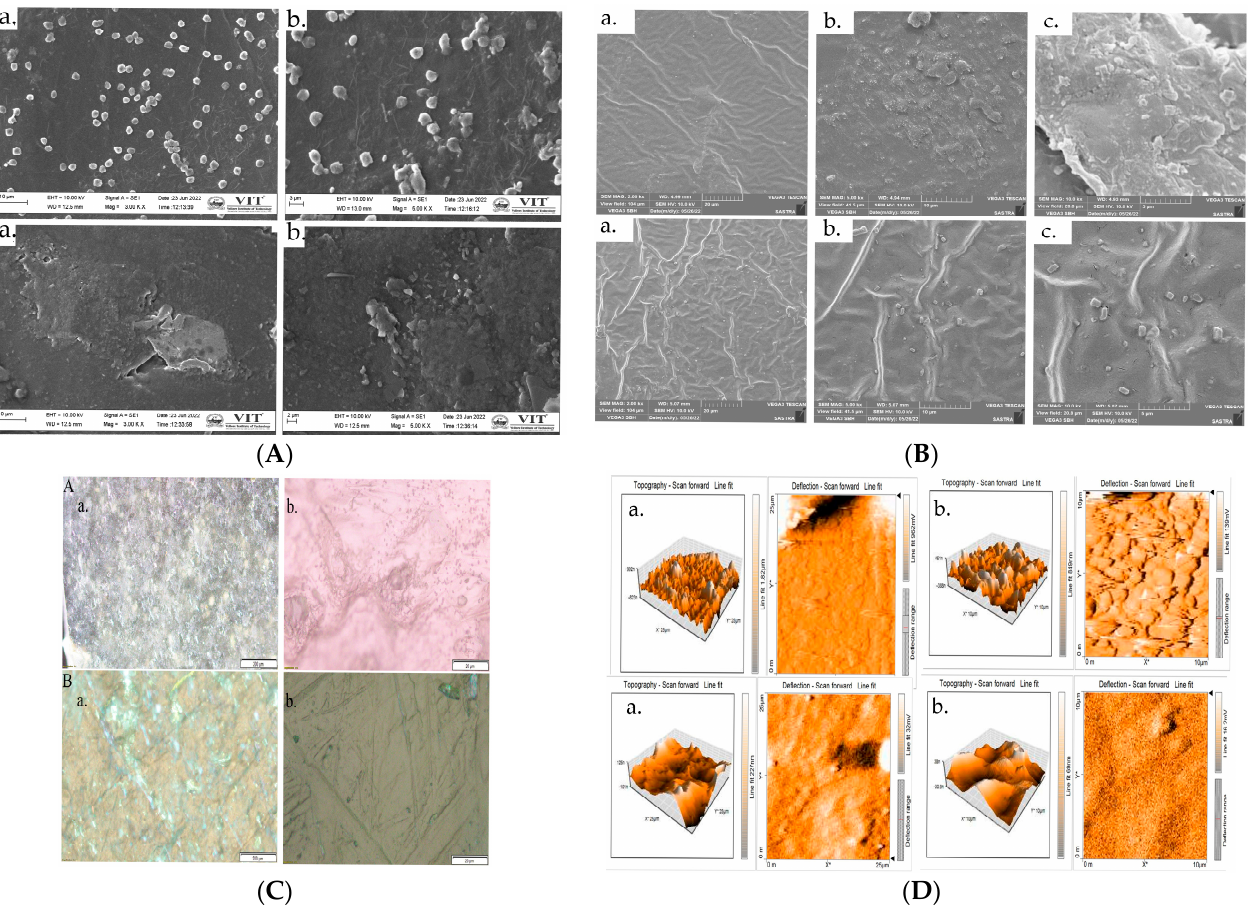
Figure 1. ( A ) SEM image of AP and APH at (a) 10 µm and (b) 2 µm. ( B ) FESEM image of AP and APH at (a) 20 µm (b) 10 µm and (c) 5 µm. ( C ) Optical image of AP and APH at (a) 200 µm and (b) 2 µm. ( D ) AFM image of AP and APH at (a) 10 µm and (b) 25 µm.